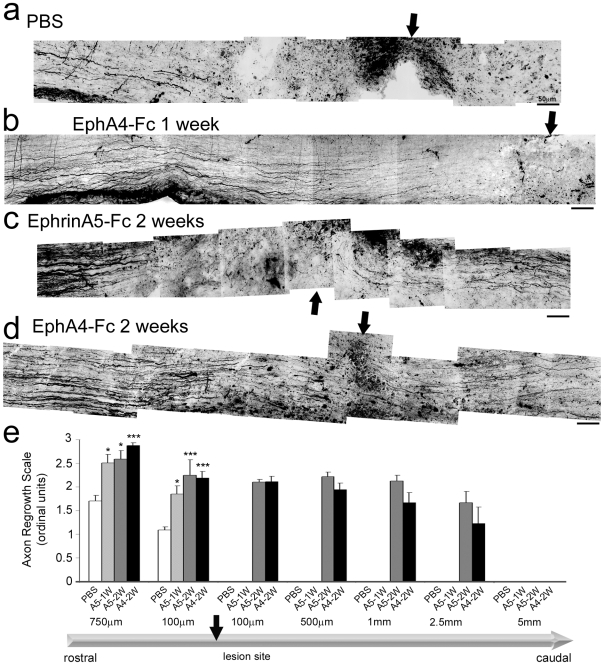
Axonal regeneration in ephrin-A5-Fc- and EphA4-Fc-treated spinal cords 6 weeks after injury.A montage of confocal images, 6 weeks after injury, from representative sections anterogradely traced with Fluoro-ruby showing that (A) PBS-treated mice had few labeled axons rostral to the lesion site. (B) One week of EphA4-Fc treatment increased the number of axons rostral to the lesion site but did not promote regeneration through it. A 2-week treatment with ephrin-A5-Fc (C) or EphA4-Fc (D) was sufficient to promote regeneration through and caudal to the lesion site. Scale bars for A–D, 50 µm. Arrows point to center of lesion site. (E) Axonal regrowth was determined by semi-quantitative analysis of labeled axons rostral and caudal to the lesion site after ephrin-A5-Fc (A5) or EphA4-Fc (A4) treatment for 1 week (1 W) or 2 weeks (2 W): ordinal scale 0 = no axons; 1 = fewer than 10 axons; 2 = 10–50 axons; 3 = more than 50 axons per section (from n≥5 sections per spinal cord). *p<0.05, ***p<0.001 compared to PBS control, using one-way ANOVA with Tukey's multiple comparison test.